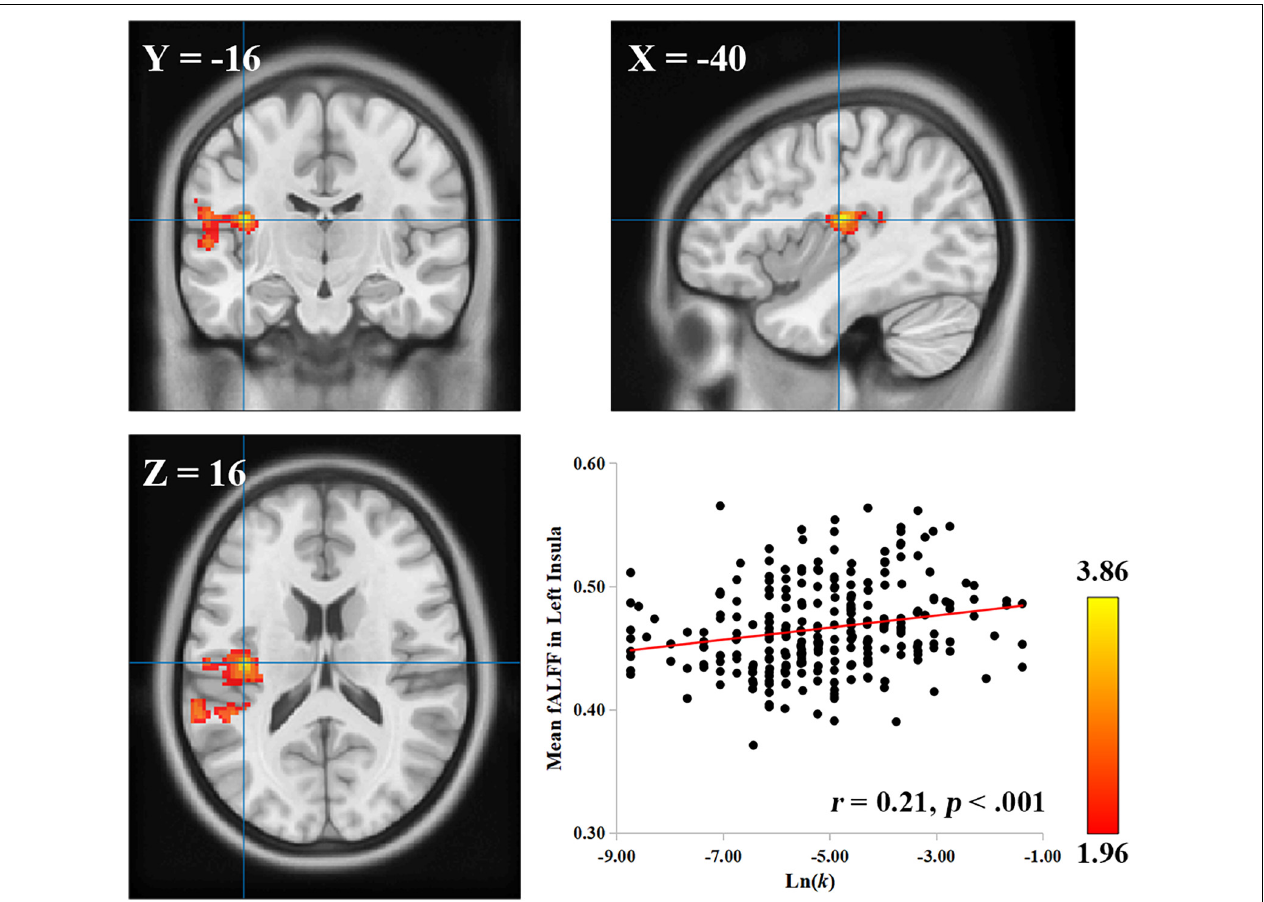
FIGURE 1 | The left insula is related to delay discounting. A cluster with a positive correlation between the fALFF value and the Ln( k ) was found in the left insula. The scatter plot between the distributions of the Ln( k ) and the mean fALFF values of the cluster after controlling for intelligence, age, gender, and head motion is shown for display purposes. Each dot represents one